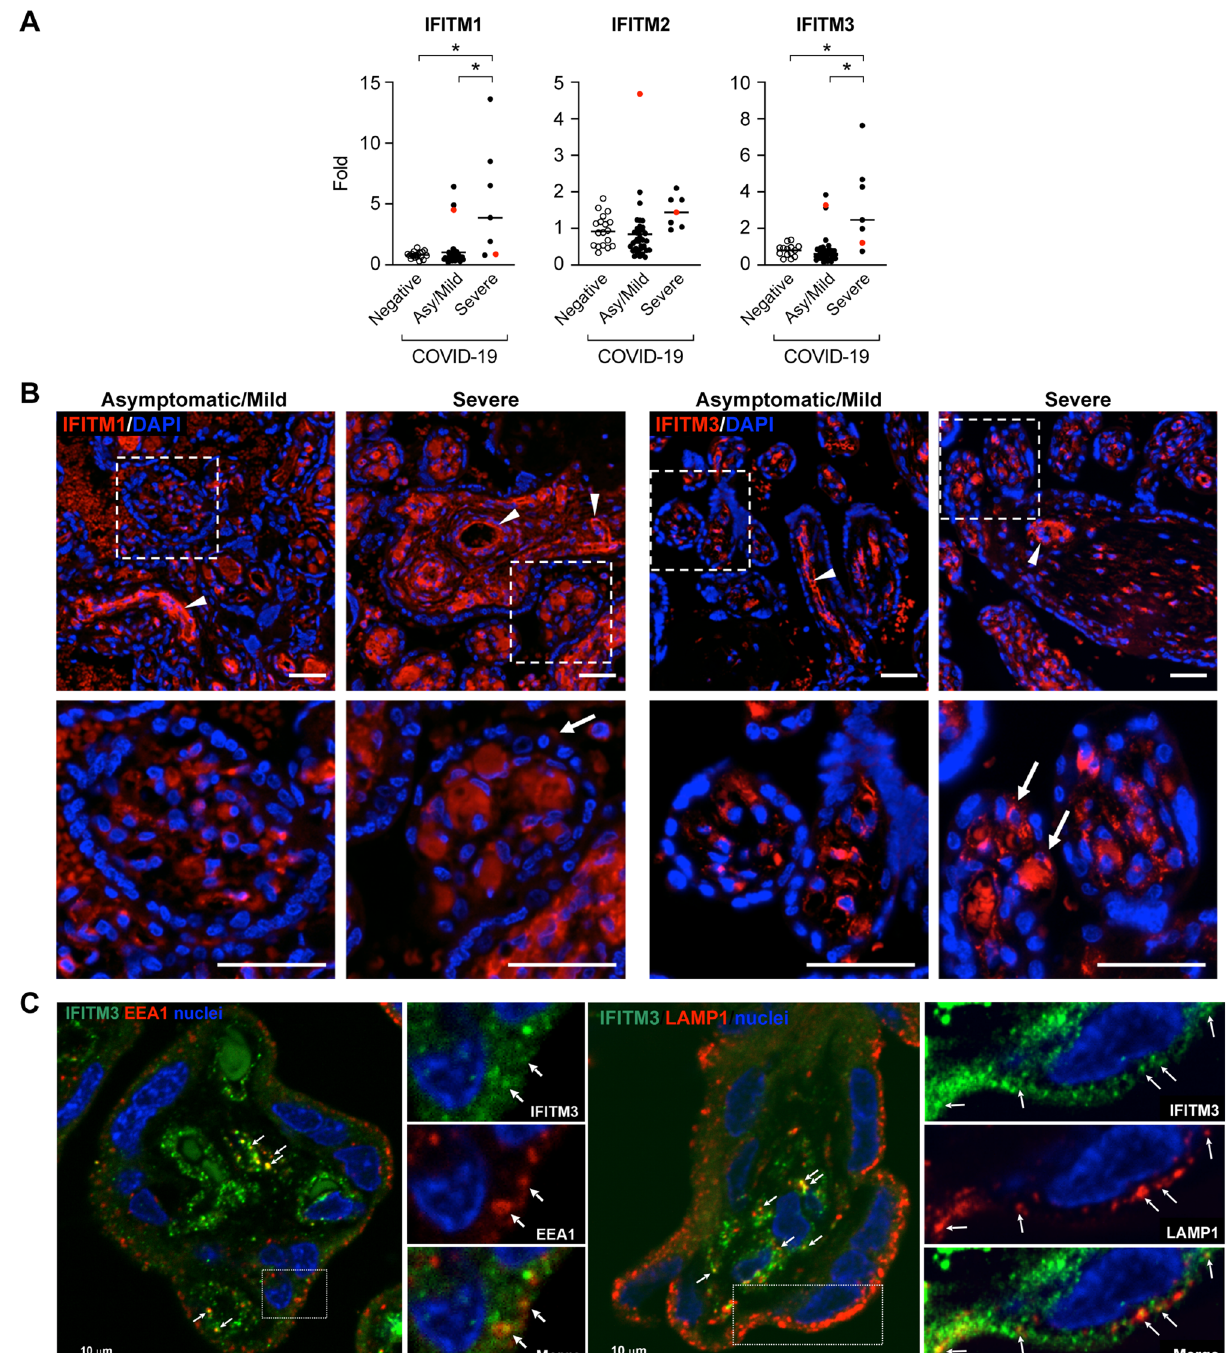
Figure 4. Placental expression of antiviral IFITM proteins. ( A ) Placental expression of IFITM1–3 mRNAs. Analysis, stratified by disease severity (asymptomatic/mild vs severe) and negative controls, was performed using RT-qPCR as detailed in “Methods”. The red dot denotes SARS-CoV-2-positive placenta. The data were analyzed using Kruskal–Wallis nonparametric test, with post hoc Tukey test for all pairwise comparisons. *Denotes p < 0.01. ( B ) Placental sections from participants with asymptomatic/mild vs severe COVID disease, stained for either IFITIM1 or IFITM3 immunofluorescence as described in “Methods”, and nuclei visualized with DAPI. Boxed areas are enlarged below. White arrowheads mark positive fetal stem villous vessels. White arrows mark rare less frequent trophoblast staining in terminal villi. Scale Bars: 50 µm. Negative-control immunofluorescence stains are shown in Supplementary Fig. 1. ( C ) Placental sections from negative-control term placentas, stained for IFITM3 immunofluorescence (green) and co-stained for either EEA1, a marker of early endosome, or LAMP1, a marker of late endosome/lysosome, as described in “Methods”. Nuclei were visualized with DAPI. Boxed areas are enlarged to the right side of each image. White arrowheads denote colocalization of IFITM3 and endosomal markers. Scale Bar: 10